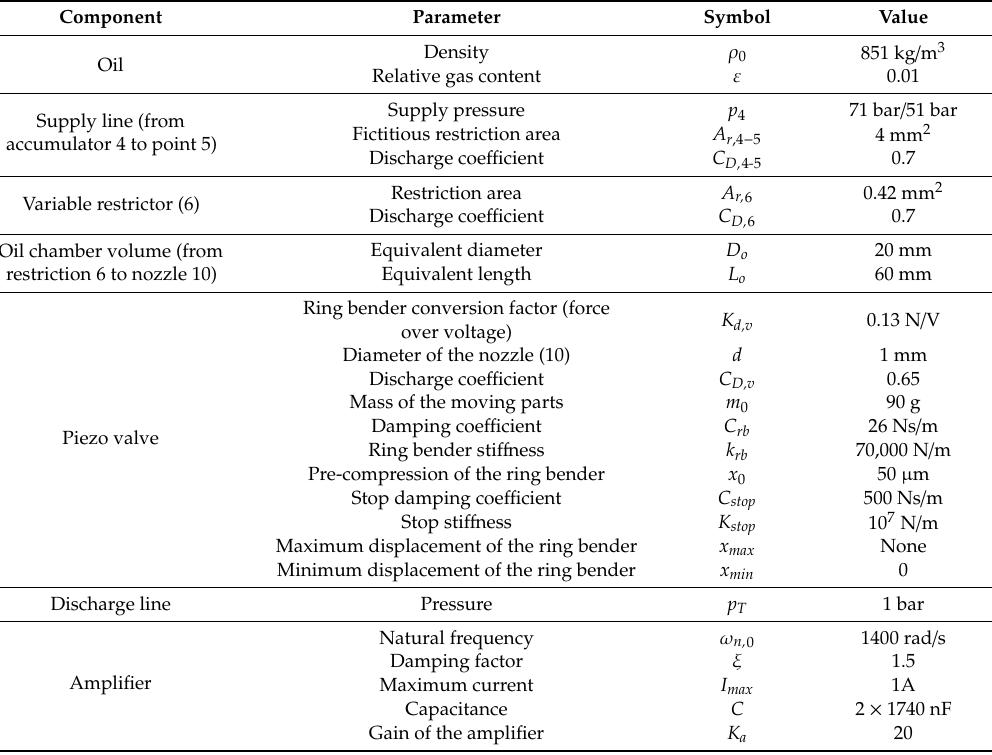
Table 2. Parameters assumed for the